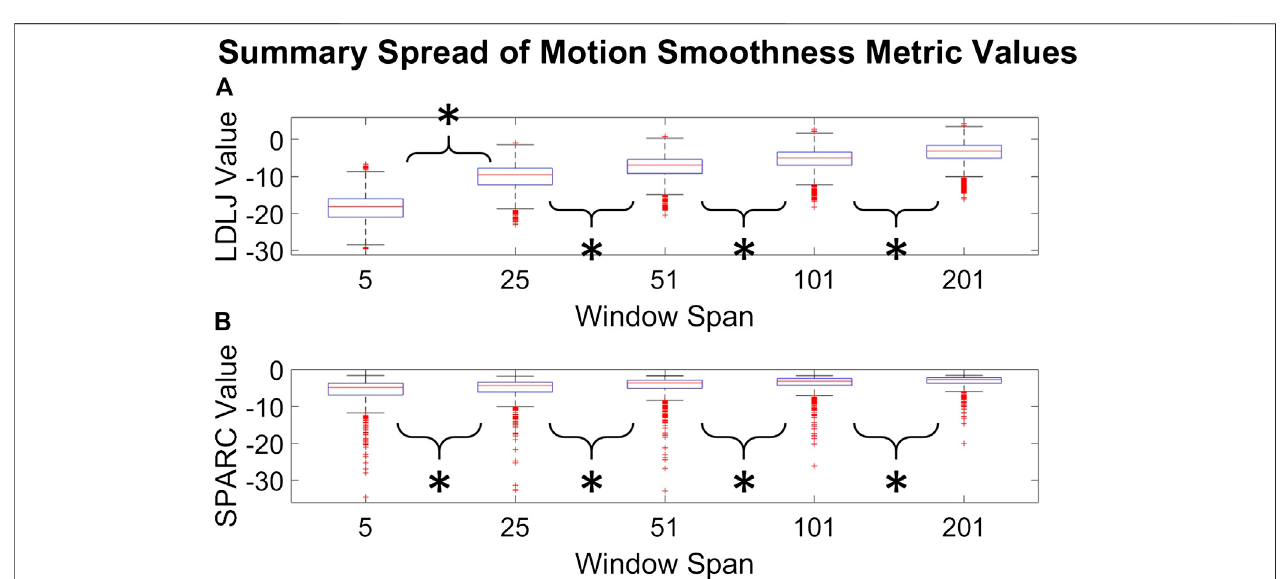
FIGURE 8 | Distributions of LDLJ [subplot (A) ] and SPARC [subplot (B) ] values for each window span. An asterisk indicates that a t-test between two distributions demonstrated statistical signi fi cance.